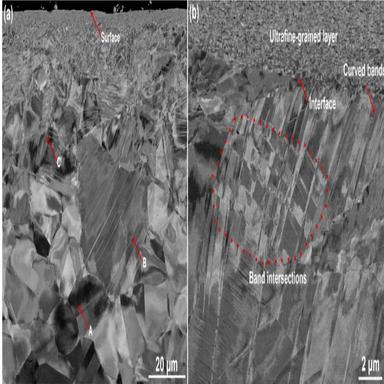
BSE images of (a) the machined-induced deformation zone on type 316 L stainless steel; (b) a high magnification image showing the details of the near surface region.